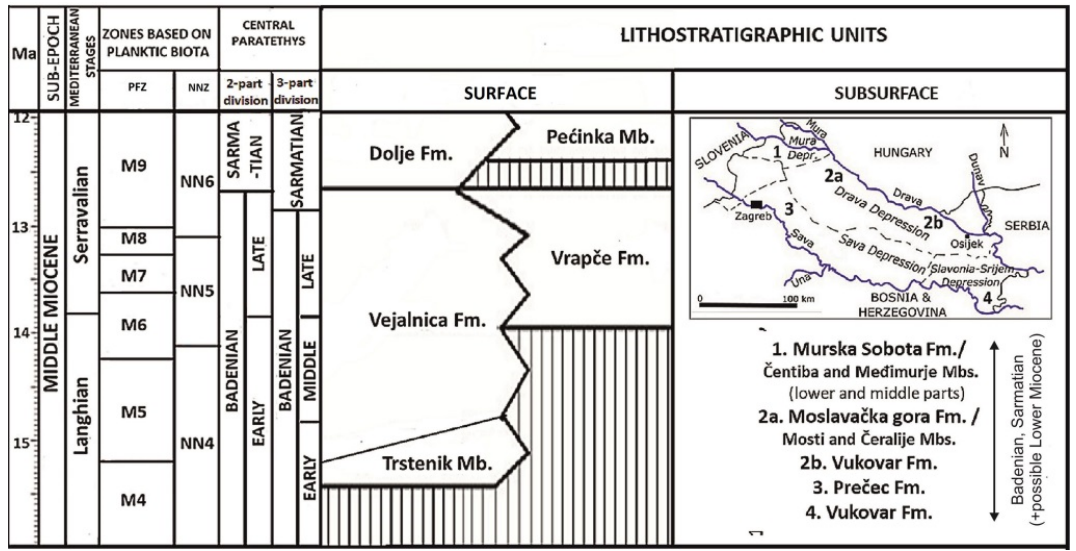
Figure 17. Correlation of chronostratigraphic, biostratigraphic and lithostratigraphic Middle Miocene units in the CPBS (after [4,13,51,132,133,148–152]). Vejalnica Formation is described on the basis of the Č u č erje Realm sequence (with previously described basinal deposits); while Dolje Formation can be compared with the younger part of the formerly described Dolje Realm succession.